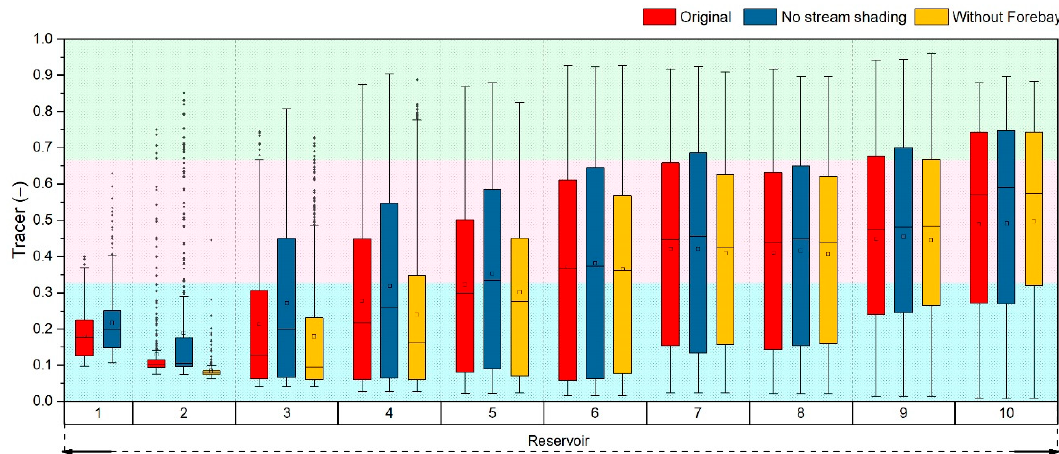
Figure 9. Box plots of tracer ratio for the original simulation and two scenarios (without the forebay and no stream shading in the catchment—indicated by the legend). Each subplot is one section, indicated by the title. The background color marks the thresholds for the three classifications of density current. Blue background represents the threshold for underflows, pink background for interflows, and green background for overflows.